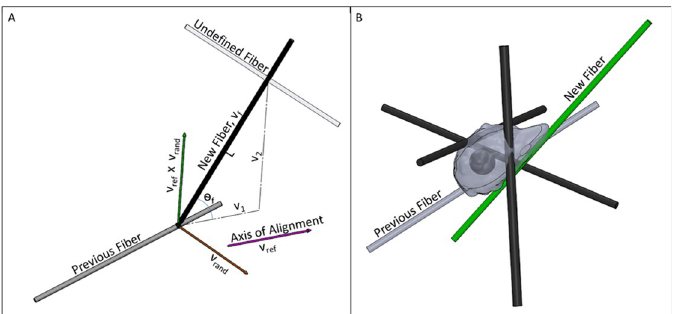
Fig 10. Stochastic fiber generation and selection. A) New fiber selection shown for fiber selection in event of a crosslink. The new fiber’s direction is determined from its length L, the angle θ f it makes with the axis of alignment v ref , and the cross product between v and v . B) In the event of a new pseudopod, multiple fibers (black and green) are ref rand stochastically generated around the cell. The cell then selects the fiber (green) that most closely follows a defined signal gradient or the cell’s extension vector (see pseudopod extension direction